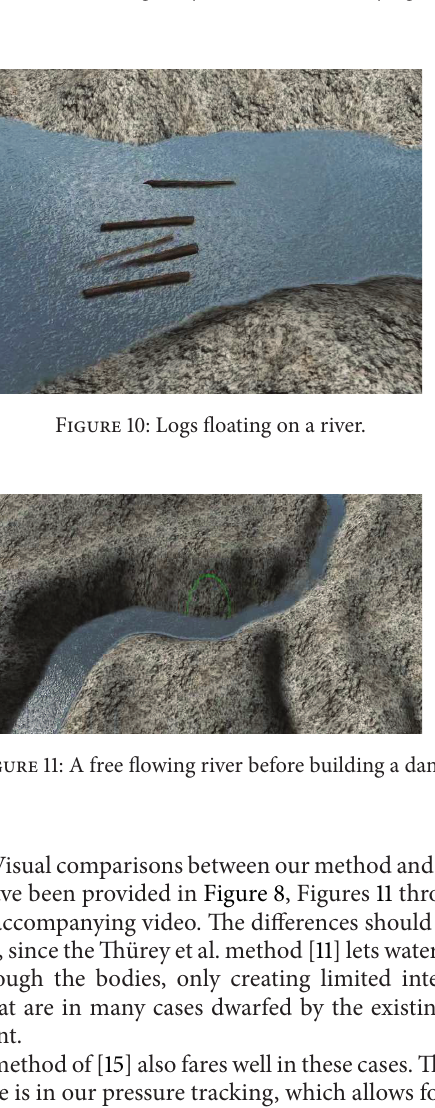
Figure 8: A visual comparison of the difference between a traditional [11] body (a) and a blocking body (our method, (b)) lying on a hill.